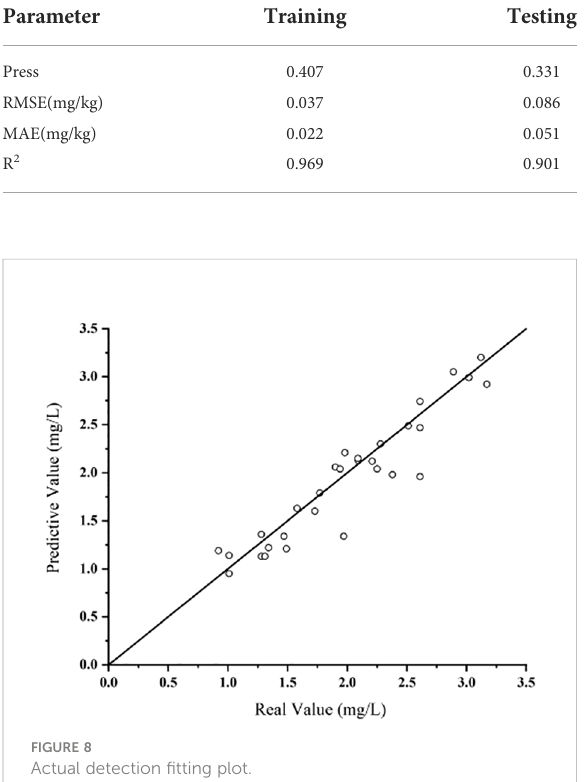
FIGURE 8 Actual detection fi tting plot.